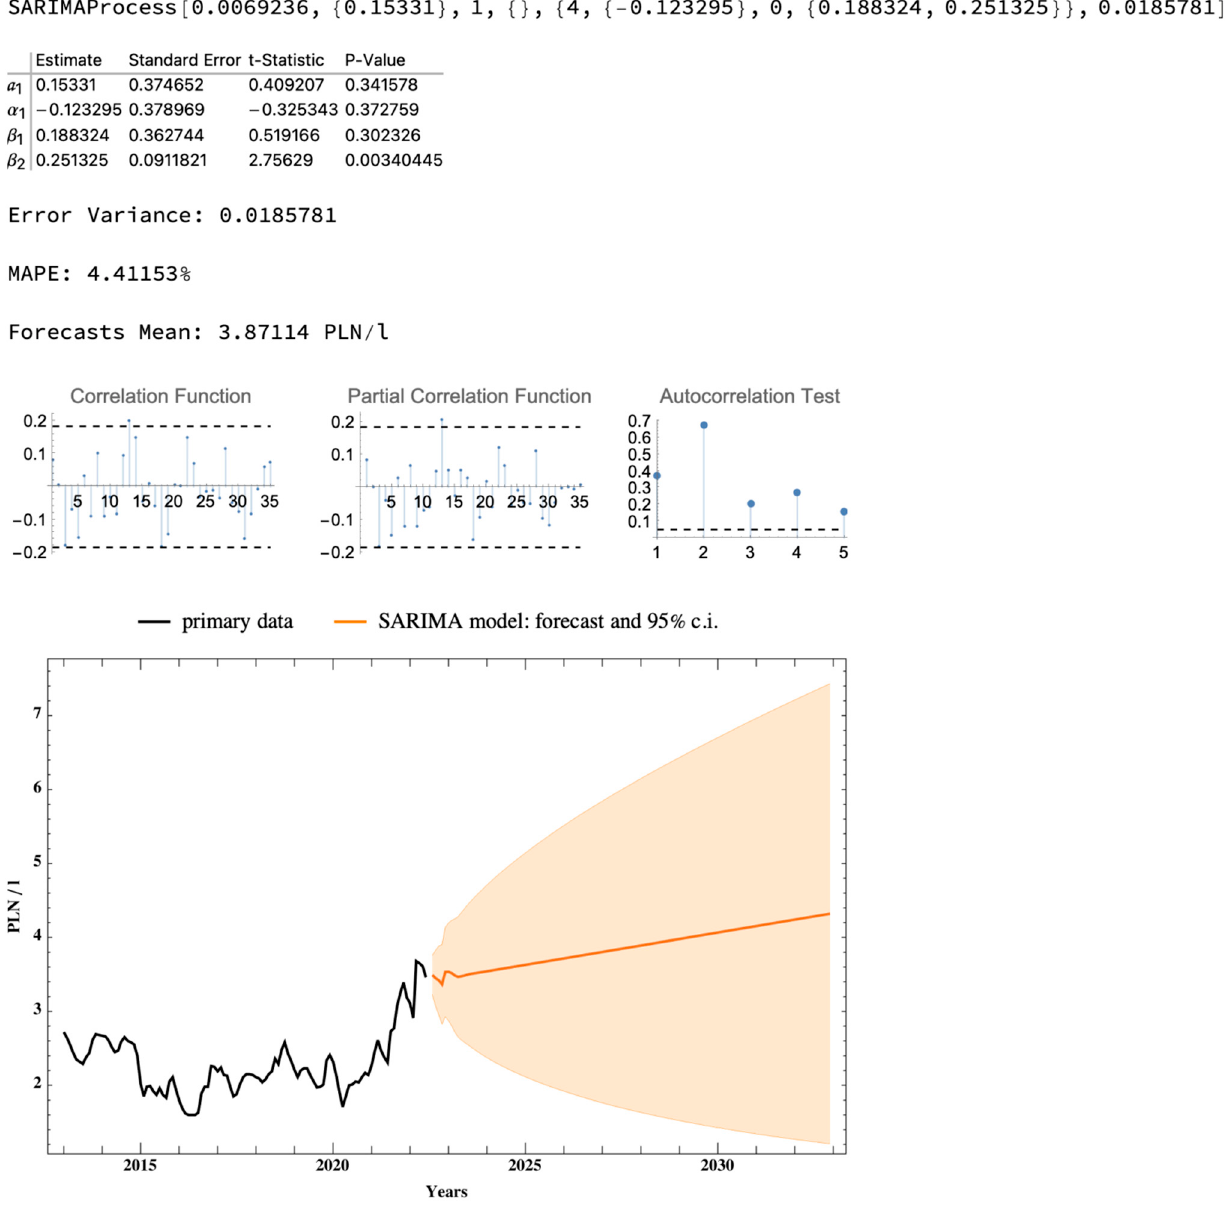
Figure 2. Results of the SARIMA model forecasting LPG prices.